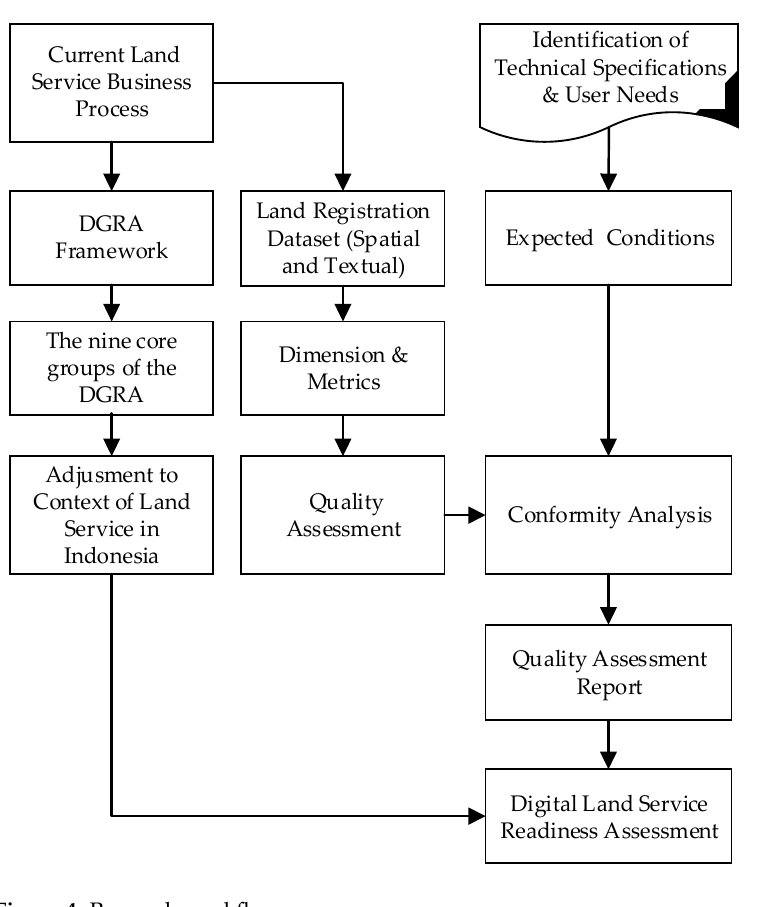
Figure 4. Research